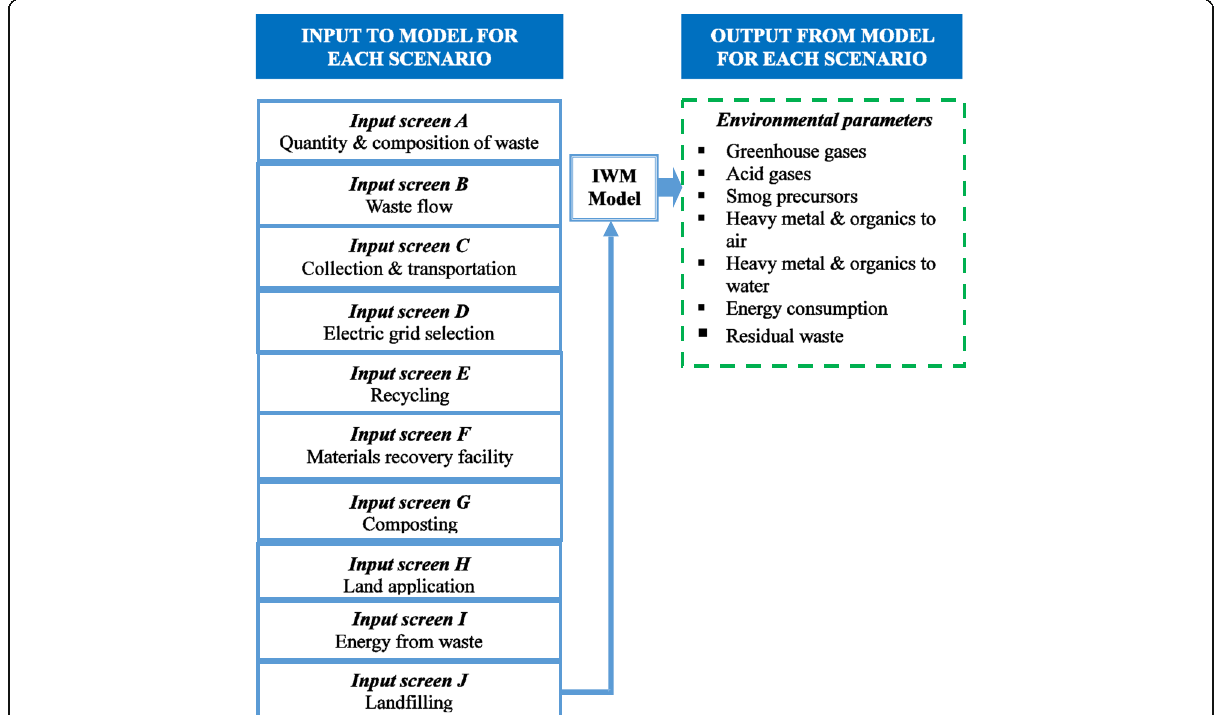
Fig. 2 Flow diagram for life cycle inventory